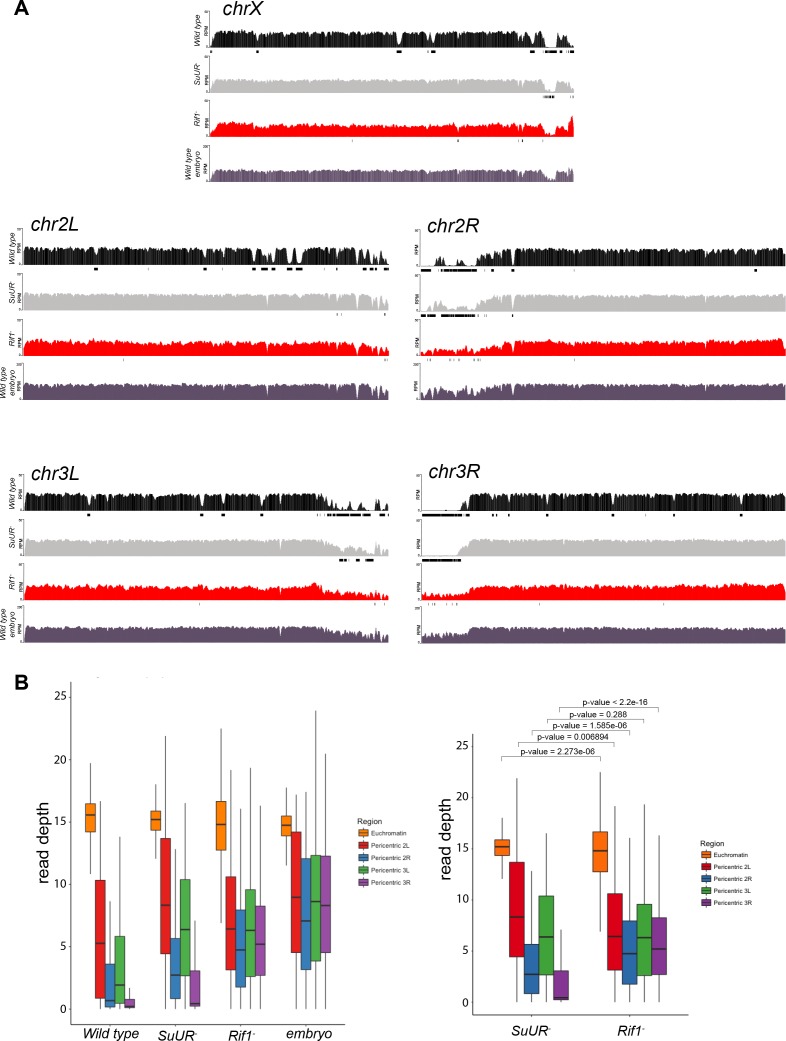
Genome-wide copy number profile of the Rif1 mutant.(A) Illumina-based copy number profiles of all chromosome arms except the fourth for larval salivary glands of the indicated genotypes. Black bars below each profile represent called underreplicated regions. (B) Box plot represents read depth in 10 kb bins in the pericentric chromatin regions for chr 2L, 2R, 3L and 3R. A Welch Two Sample t-test was used to compare the same regions between SuUR and Rif1 mutants. The same wild-type, SuUR and 0 – 2 hr embryo plots as in Figure 1—figure supplement 1.